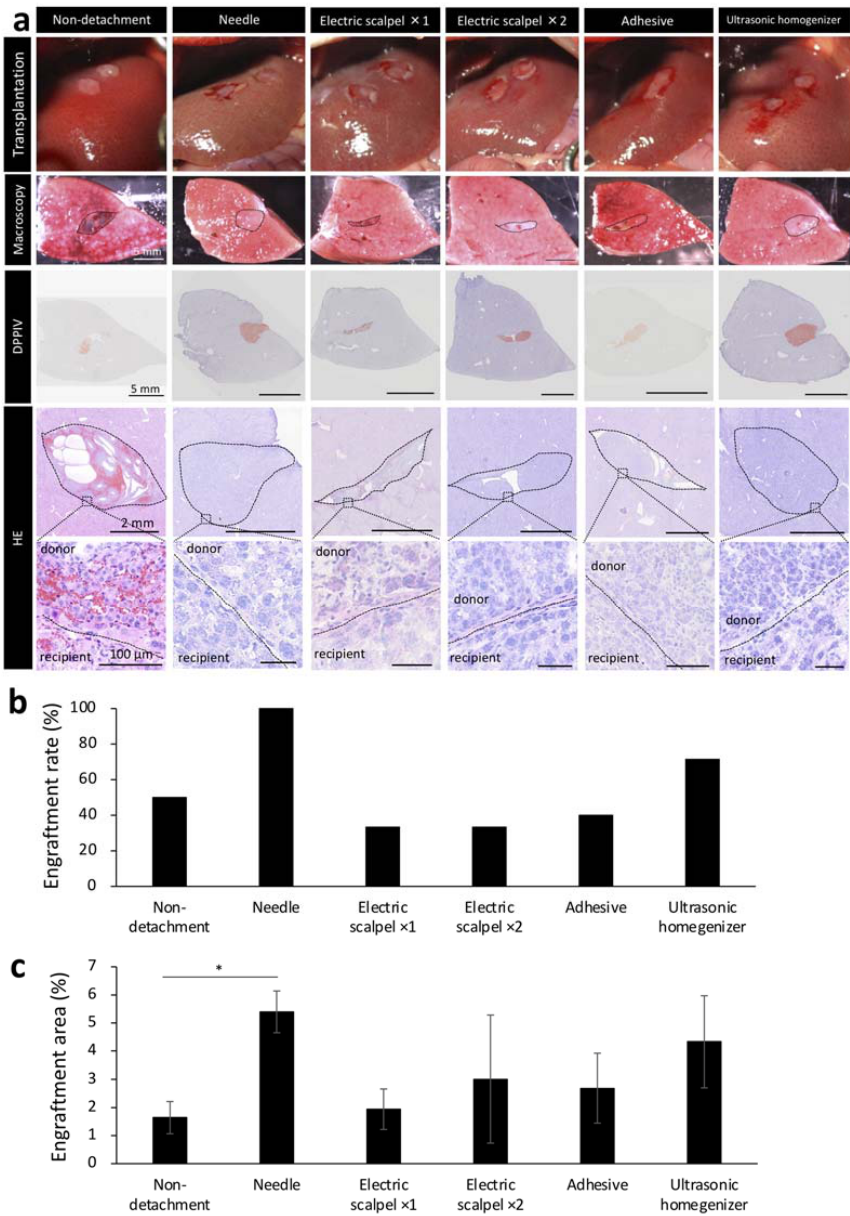
Figure 3. Engraftment efficiency and histological evaluation of fetal livers transplanted using different detachment methods. ( a ) The first images show the condition after transplantation of fetal livers with or without serous membrane detachment. The second images show macroscopic images of the cut surface of the liver three weeks after transplantation. Frozen sections of these tissues were stained with hematoxylin/eosin (HE) and Dipeptidyl Peptidase-4 (DPPIV). DPPIV-positive areas are stained orange. ( b ) Fetal liver engraftment rates at three weeks after transplantation (non-detachment, n = 6; needle, n = 7; electric scalpel ×1, n = 6; electric scalpel ×2, n = 6; adhesive, n = 6; ultrasonic homogenizer, n = 7). ( c ) Areas positive for DPPIV was divided by the area of entire recipient liver including the donor to calculate DPPIV expression level. ImageJ was used for analysis (non-detachment, n = 6; needle, n = 7; electric scalpel ×1, n = 6; electric scalpel ×2, n = 6; adhesive, n = 6; ultrasonic homogenizer, n = 7). The data are shown as the mean ± standard error. * p < 0.05 versus non-detachment group by non-repeated measures analysis of variance with Bonferroni correction.